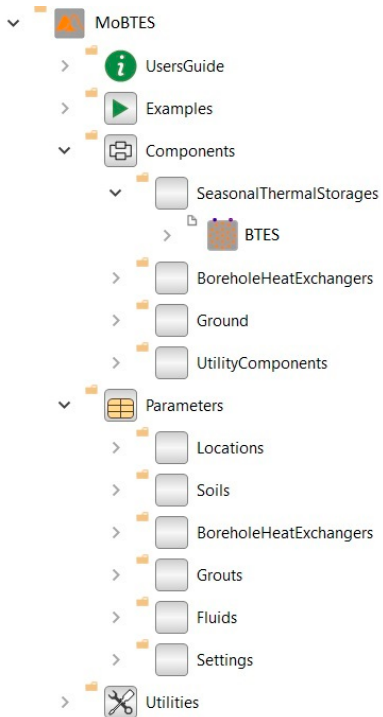
Figure A1. MoBTES Modelica library structure.